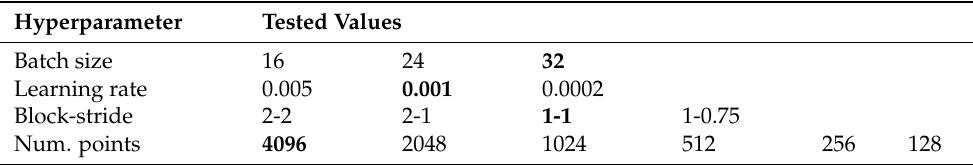
Table 1. Tested hyperparameter values. Original values are marked in bold.